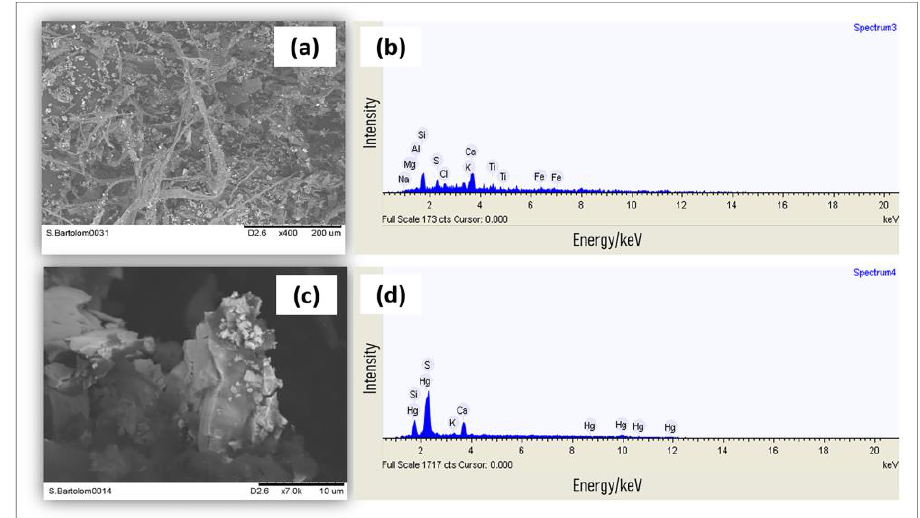
Figure 9. ( a ) SEM image of the dust deposited on the wooden sculptures (area = 0.80 mm × 0.60 mm, 400× magnification). ( b ) EDX spectrum of the image presented in ( a ). ( c ) Point image of the dust deposited on the wooden sculptures (Area = 0.04 mm × 0.03 mm, 7000× magnification). ( d ) EDX spectrum of the image presented in ( c ). Experimental parameters: accelerating voltage = 15 kV; working distance = 6500 µm; emission current = 65 mA; acquisition time = 150 s.